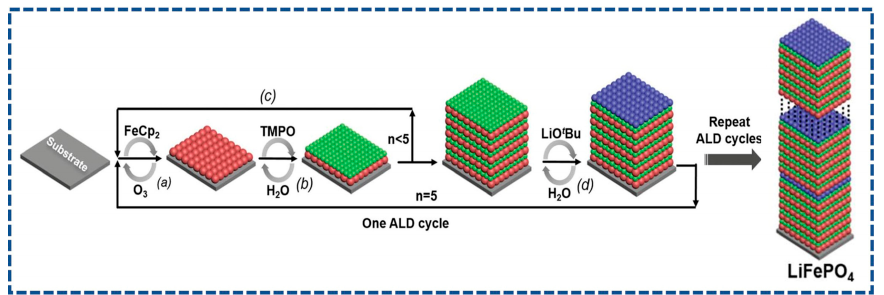
Figure 5. ALD synthesis of amorphous LiFePO 4 at 300 °C using the FeCp 2 , O 3 , trimethylphosphate (TMPO), H 2 O, and lithium t -butoxide (LiO t Bu). ( a ) Sequential pulse of FeCp 2 and O 3 leading to the growth of a Fe 2 O 3 layer (red); ( b ) sequential pulse of TMPO and H 2 O for deposition of a PO x layer (green); ( c ) steps ( a , b ) are repeated five times; ( d ) sequential pulse of LiO t Bu and H 2 O leading to formation of Li 2 O layer (blue). One ALD cycle for the growth of amorphous LiFePO 4 consists of steps